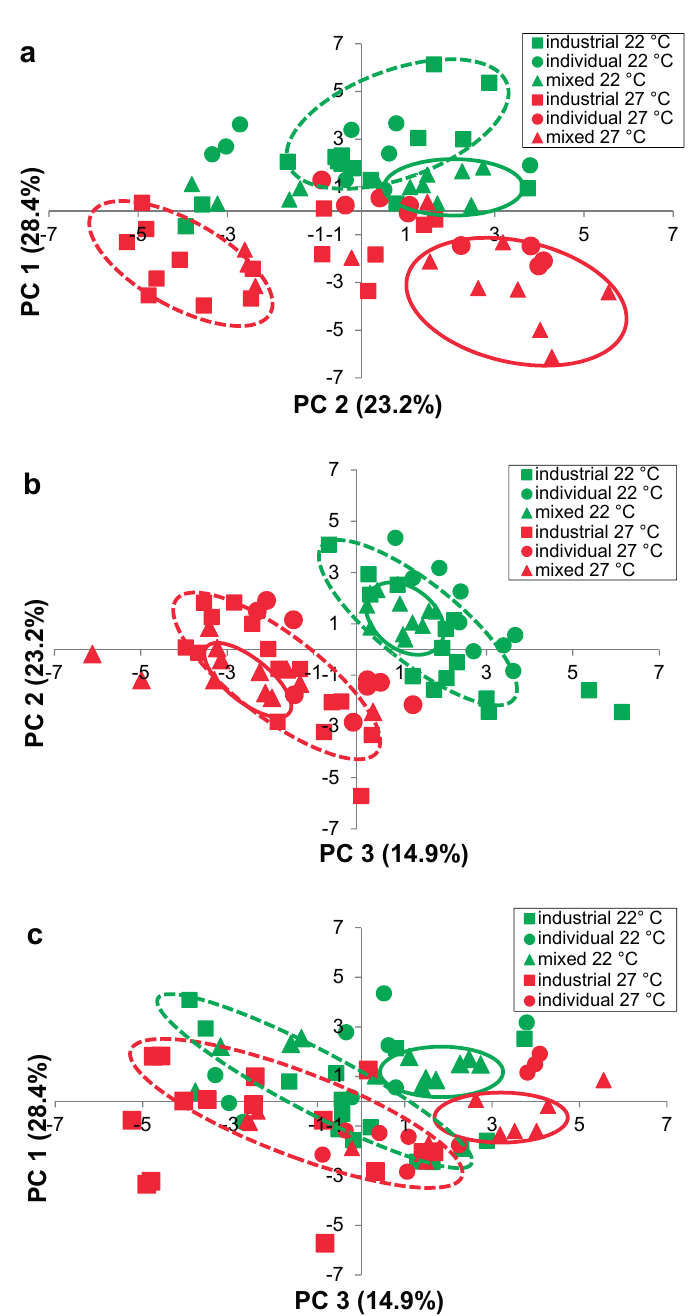
Figure 4. Principal component analysis (PC 1, PC 2, PC 3) of the mean concentration of 25 volatile compounds in Pinot noir, fermented using five industrial yeast strains (squares), three individual-Burgundian (circles) and four mixed-Burgundian (triangles) S. cerevisiae isolates in triplicate, at 22 °C (green) and 27 °C (red) ( a ) plot of PC 1 versus PC 2 ( b ) plot of PC 1 versus PC 2 and ( c ) plot of PC 1 versus PC 3. Ellipses drawn around wine fermented with industrial strains (dashed lines) and mixed-Burgundian isolates (solid lines), at 22 °C (green) and 27 °C (red), are to aid in discussion